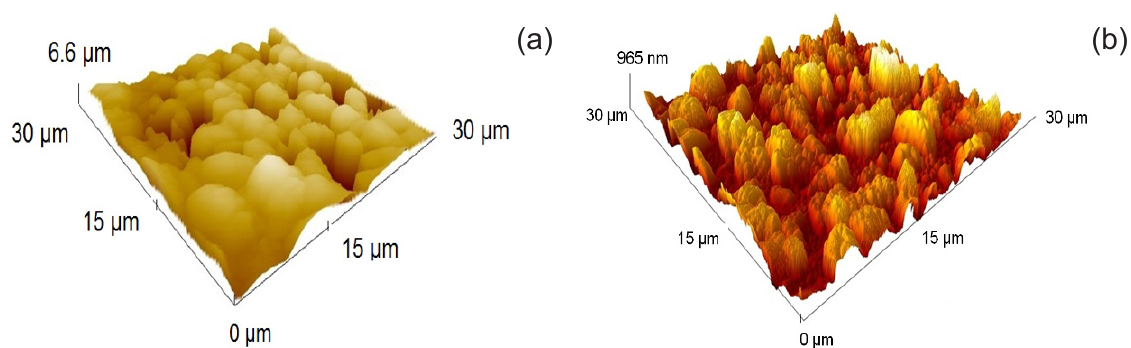
Figure 7. AFM image of Tl